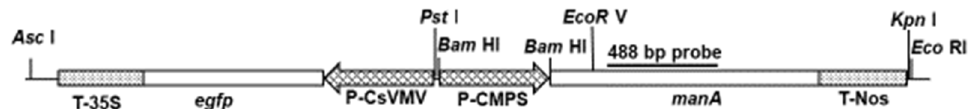
5 of 11 Figure 2. Southern blot analysis using a probe of the man A coding region: C17-22, C25-26 : Citrus sinensis Osb. x Poncirus trifoliata L. Raf. (‘Carrizo’ citrange) transgenic lines digested with Eco RI, S23-